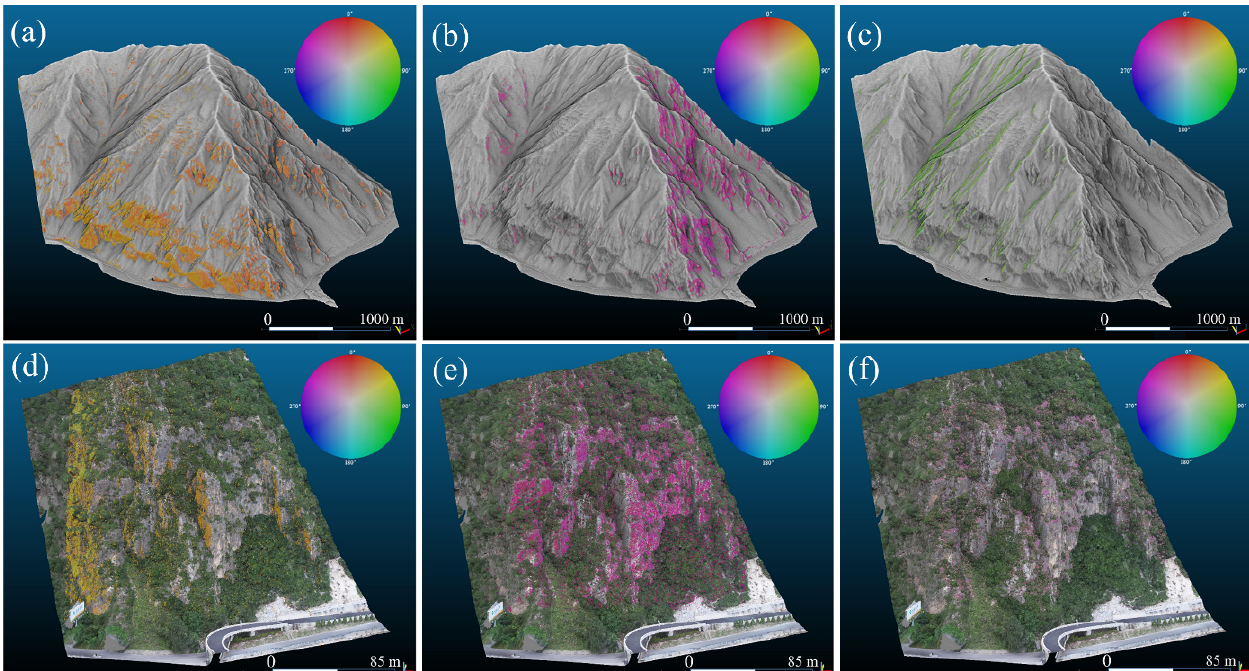
Figure 6. ( a , c ) Rock structure rendered based on Hough’s normal of the ALS and SfM points; ( b , d ) rock structure identified based on the ALS and SfM points coloured according to Hough’s normal using HSV wheel.